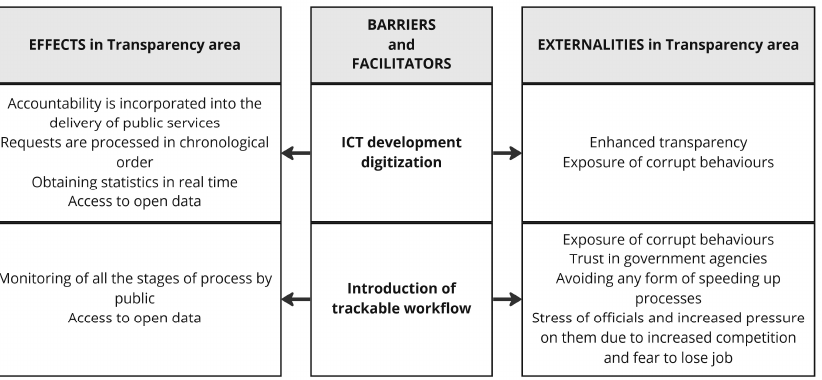
Figure 6. Barriers or facilitators, e ff ects, and externalities of smart governance implementation in the Transparency area. Source: generated by the authors. Transparency area. Source: generated by the